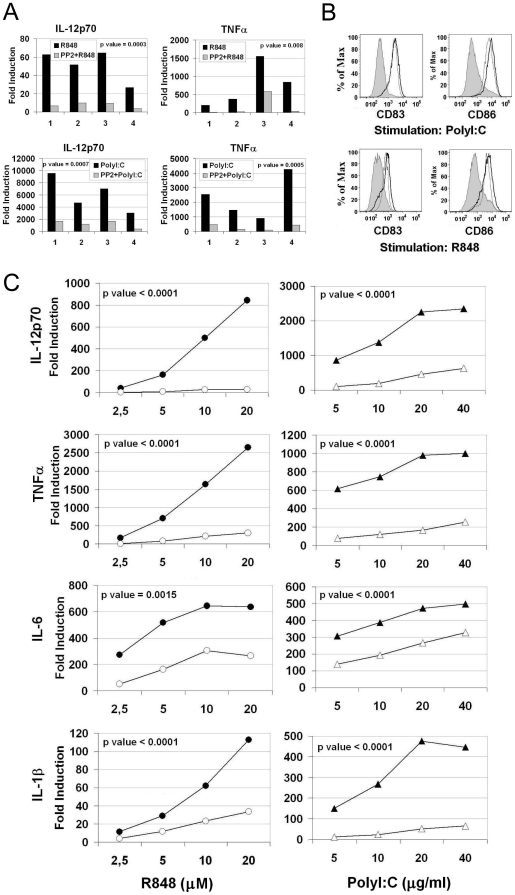
Src kinases inhibition results in uncoupling of cytokines production from up-regulation of co-stimulatory molecules.(A and B) Human MoDC were pretreated or not with PP2 (20 µM) and stimulated with PolyI∶C (20 µg/ml) or R848 (10 µM). (A) Cytokines released in the supernatants were detected after 24 hours of stimulation. Fold induction for the levels of each cytokine compared to unstimulated cells is plotted. Data from four independent experiments and the p values for the differences between the two experimental groups are shown (p value <0.05 is significant). (B) Surface expression of CD83 and CD86 was analyzed by flow cytometry after 36 hours of stimulation. Stimulated cells are represented with black line histogram, PP2-treated and stimulated cells are in grey line and untreated cells are in filled grey histogram. (C) MoDC were pretreated (open symbols) or not (filled symbols) with PP2 (20 µM) and stimulated with increasing concentrations of PolyI∶C and R848. Cytokines production was analyzed at 24 hours. Average fold induction of three independent experiments for the levels of each cytokine compared to unstimulated cells is plotted and the p values for the differences between the groups are shown (p value <0.05 is significant).